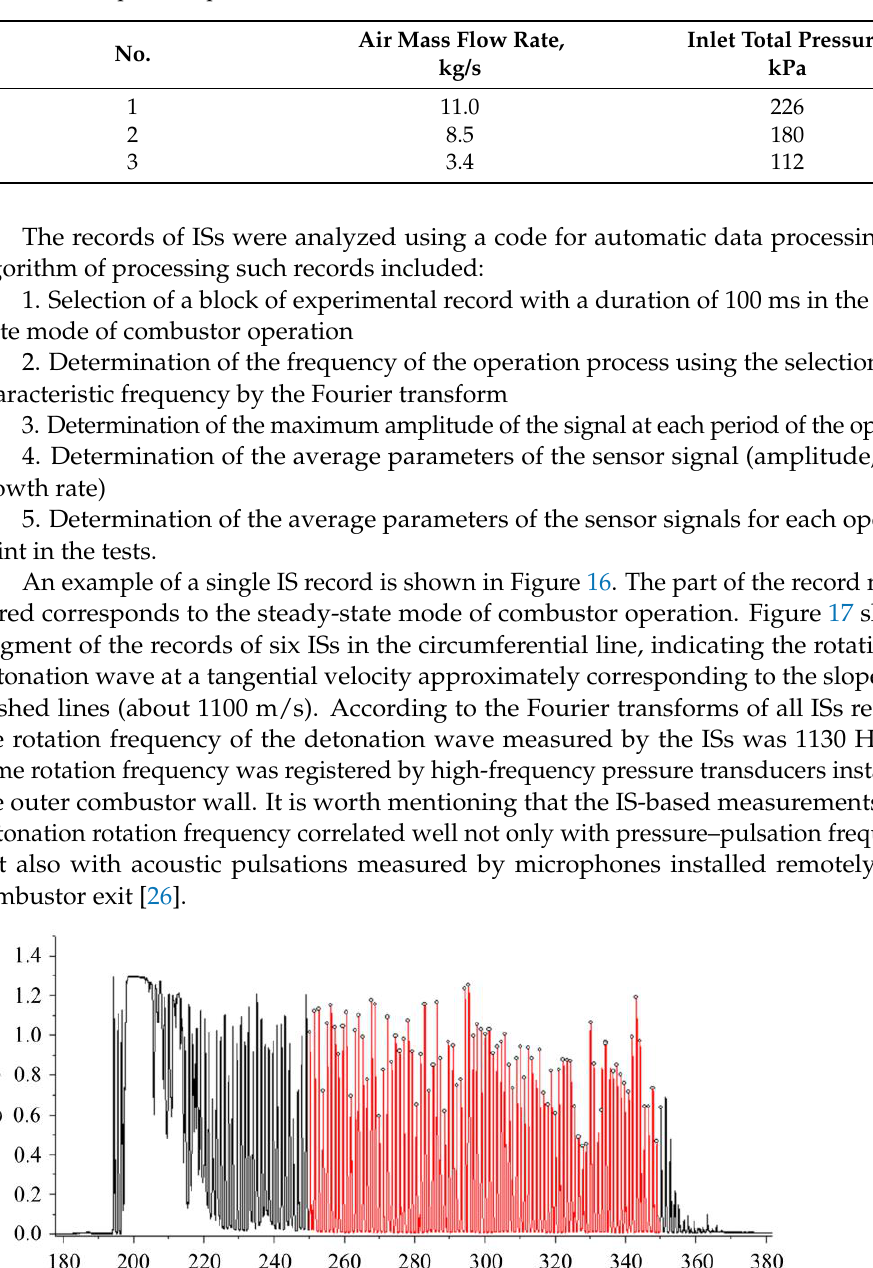
Table 5. RDE operation parameters.